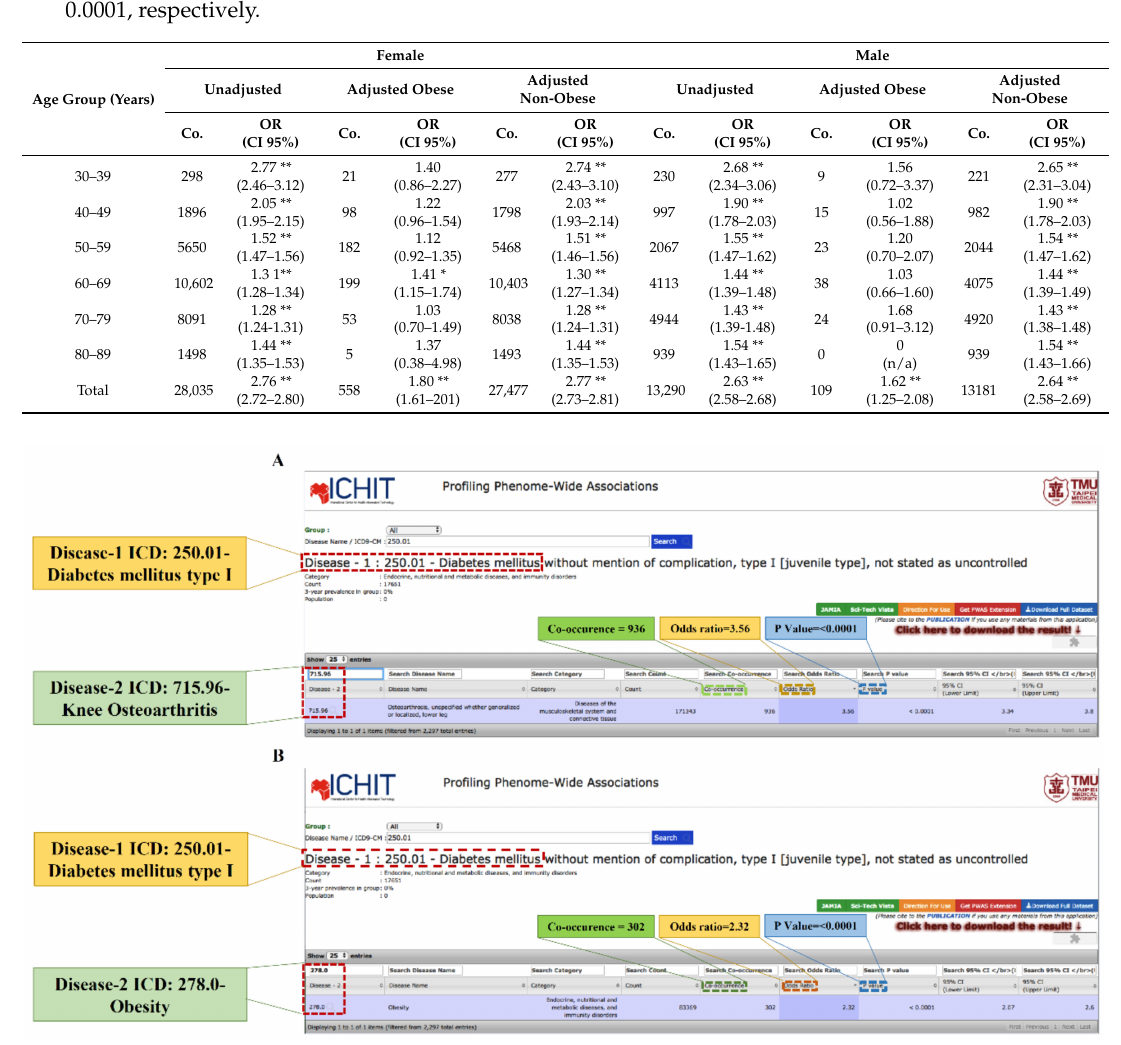
Figure 3. Screenshot of PWAS portal displaying the association between ( A ) T1DM and KOA and ( B ) T1DM and obesity. DM: Diabetes mellitus, T1DM: Type 1 diabetes mellitus, KOA: Knee osteoarthritis, and PWAS: Phenome-wide association study.